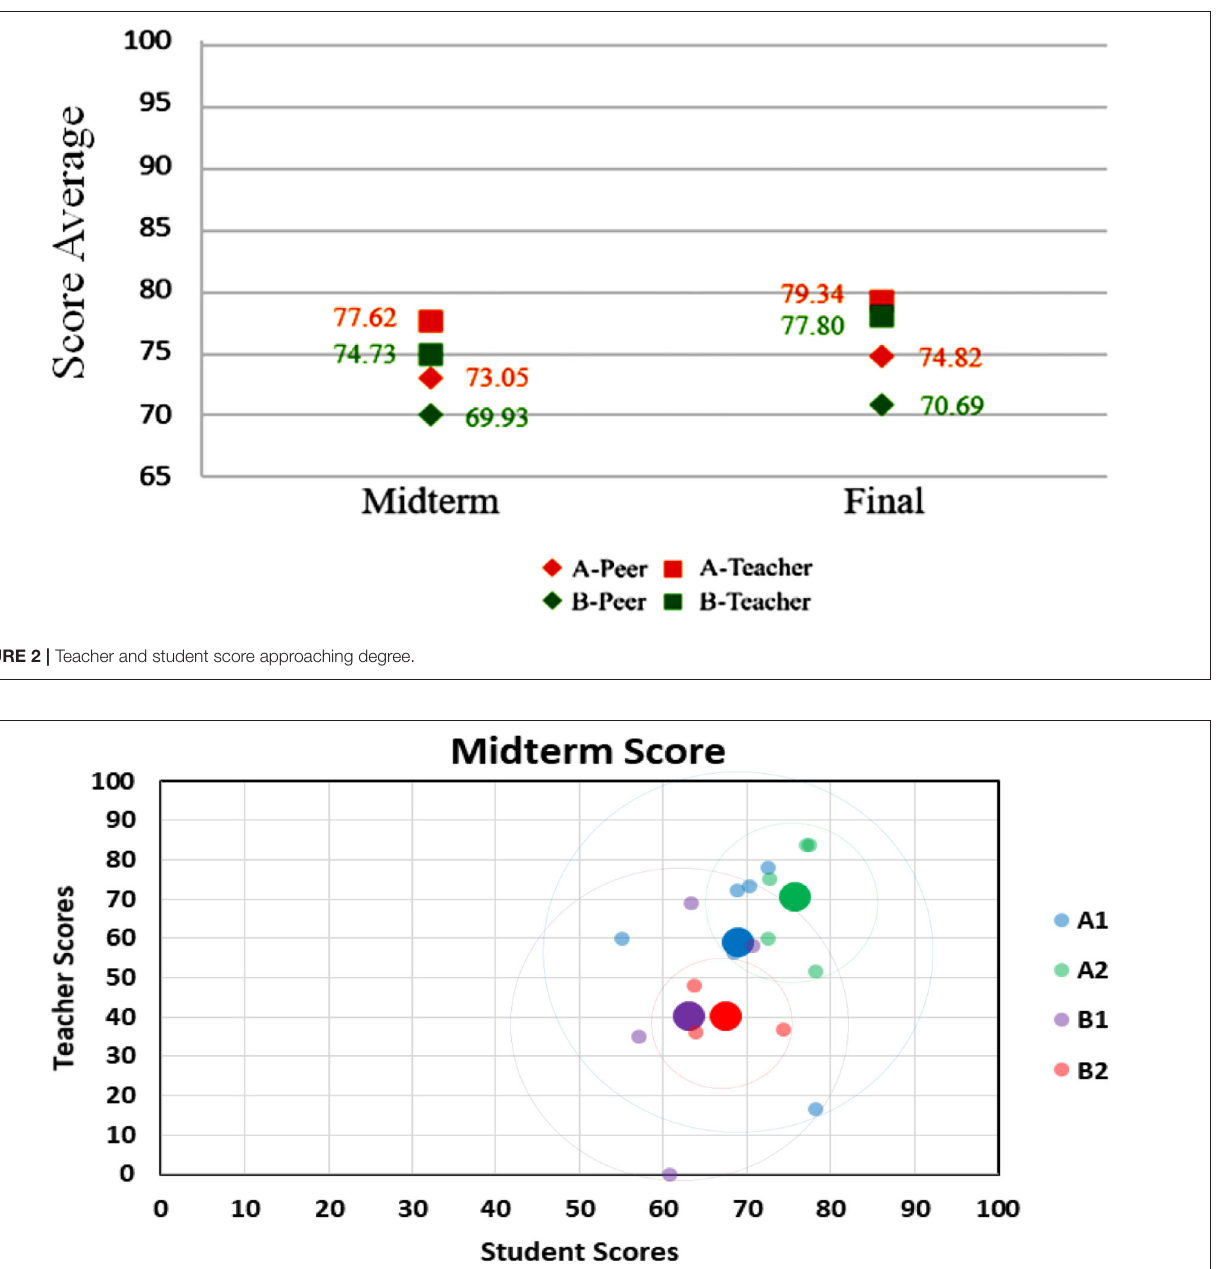
FIGURE 3 | Midterm score approach: classes A1, A2, B1, and